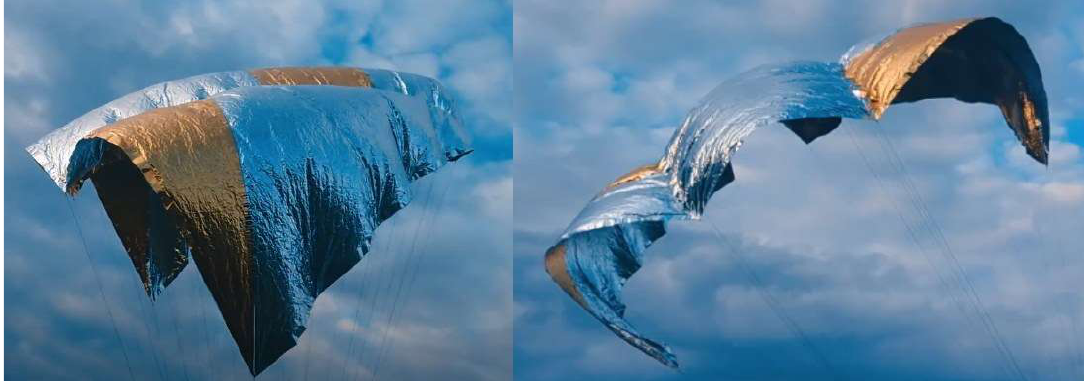
Figure 8. NPW21 parawing.